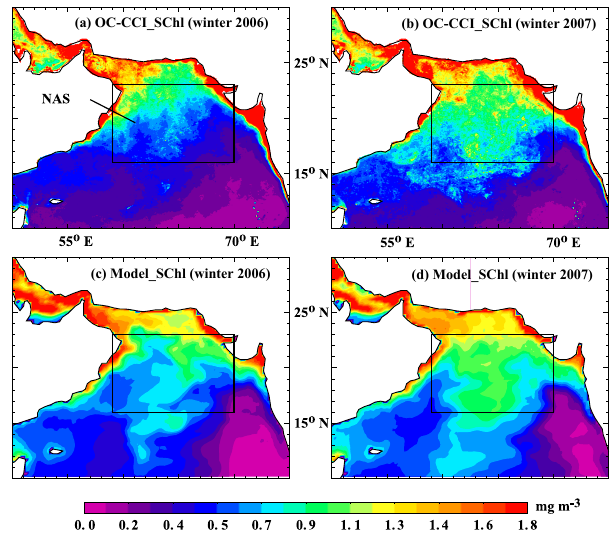
Figure 1. Arabian Sea average SChl for the winter (DJFM) of (a, c) 2006 and (b, d) 2007 in (a, b) OC-CCI product and (c, d) model. The NAS (North Arabian Sea) box (59–70 ◦ E, 16–23 ◦ N) is indi- cated by a black frame for future